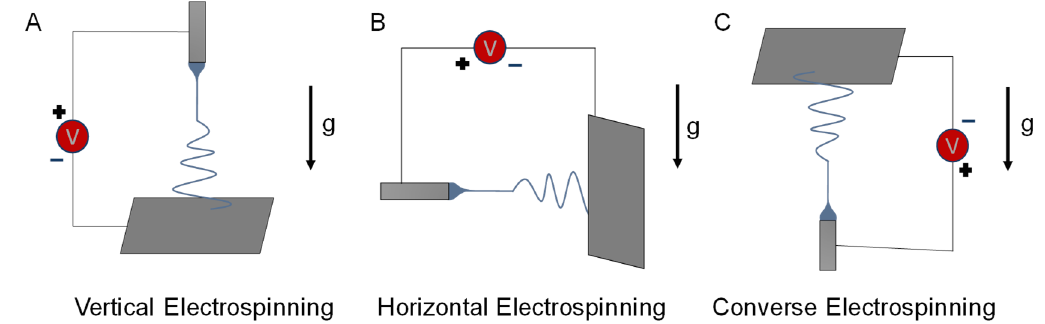
Figure 6. A schematic illustration of the different electrospinning modifications made by changes in orientation of the electrospinning. The effect of gravity causes changes in the resultant nanostructures and affects the electrospinning process.